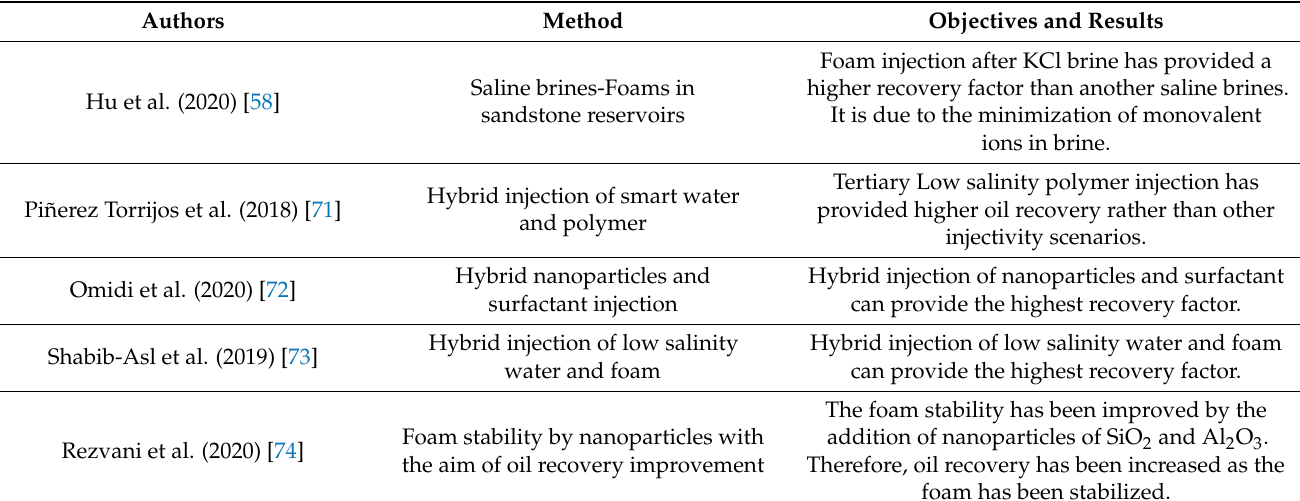
Table 1. A summary of previous hybrid injectivity